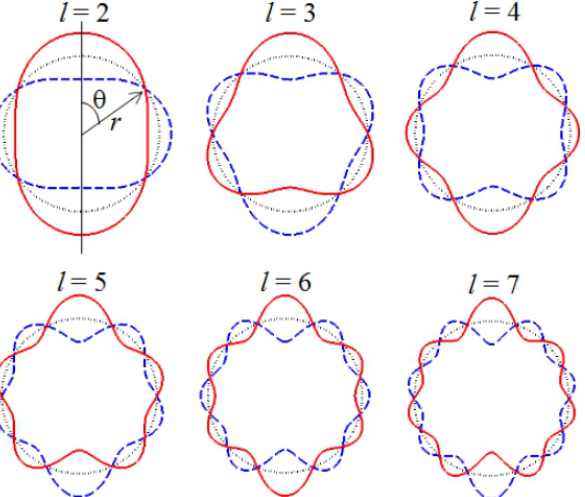
Figure 9. Cross-sections of theoretical 3D shapes assumed by a liquid drop at T l = 0 (dashed curves), T l = 1 (solid curves) and T l = 1/2 (dotted curve), where T l = ω l t is given in the units of π radians and T l = 1 corresponds to a half of a drop oscillation period corresponding to mode number l